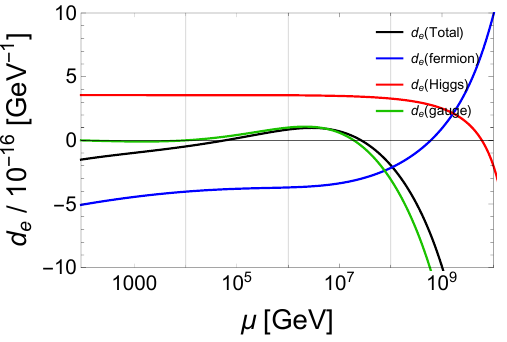
Figure 12 . RGE running of the electron EDM from m Z with the benchmark parameters given in table